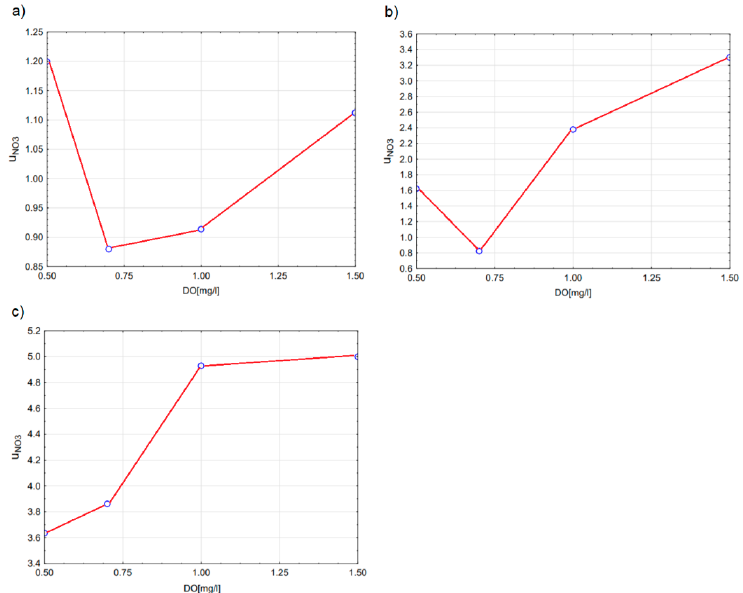
Figure 5. Influence of DO on the μ NO3-N (NOB) value for: ( a ) T = 10 °C, ( b ) T = 16 °C, ( c ) T = 30 °C.